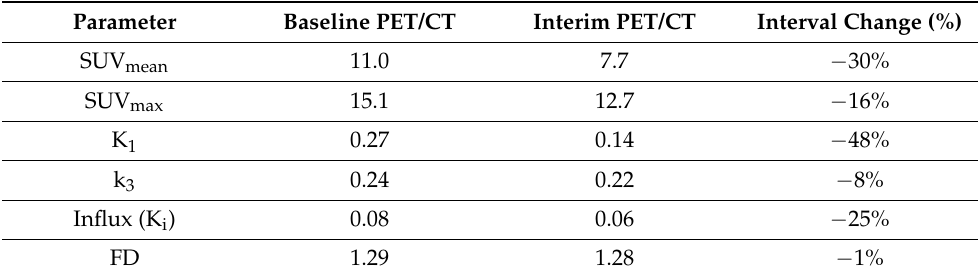
Table 3. Median values of the 18 F-FDG semiquantitative and quantitative parameters, derived from the hottest melanoma lesion for each patient, before and after two cycles of anti-PD-1 therapy, as well as their interval changes (%) as a response to treatment. The units of parameters K 1 , k 3 and influx are 1/min. SUV mean , SUV max and FD have no